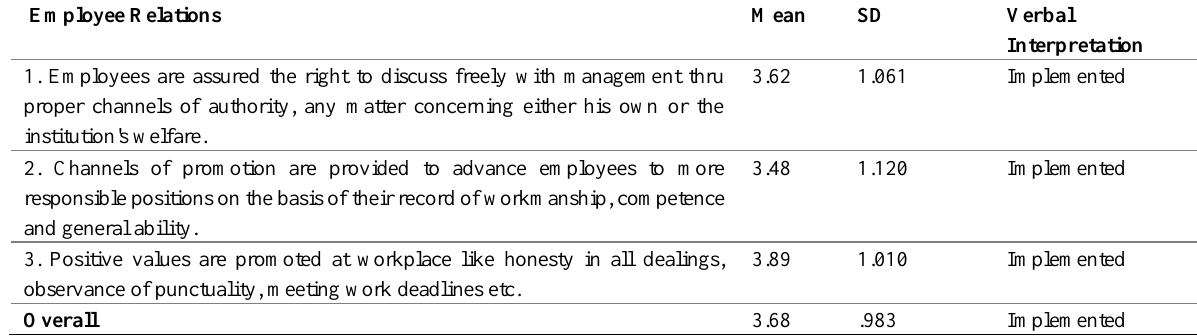
Table 8: Extent of Implementation of Excellence to Employee Relations as Perceived by Respondents Employee